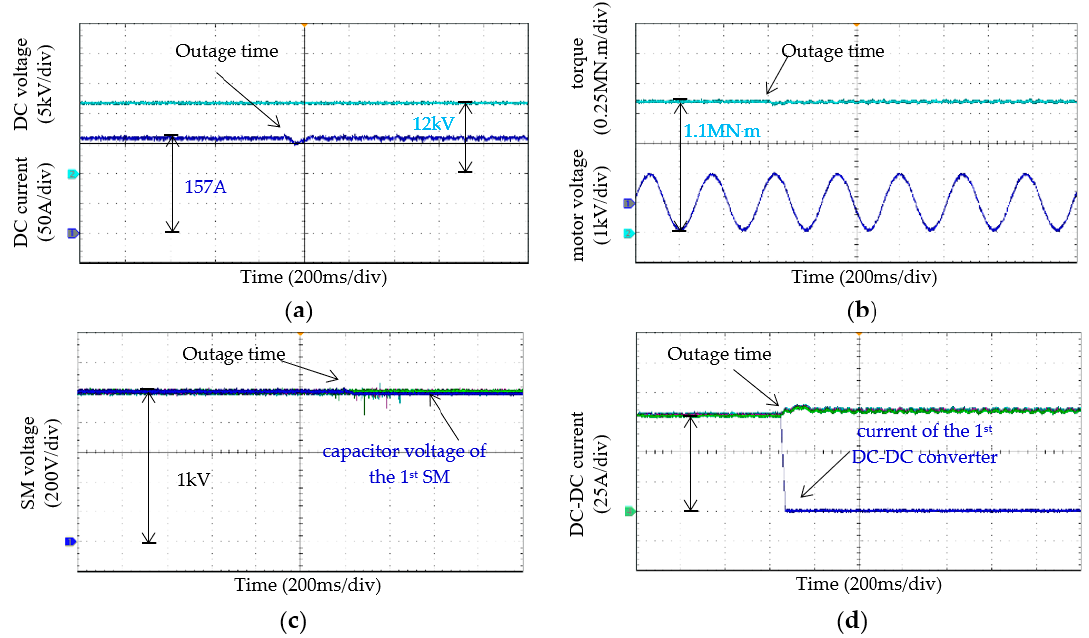
Figure 10. Experiment results when one DC–DC converter broke down: ( a ) DC transmission voltage and current; ( b ) Terminal voltage of PMSG and electromagnetic torque; ( c ) SM capacitor voltages; ( d ) Currents of DC–DC converters.